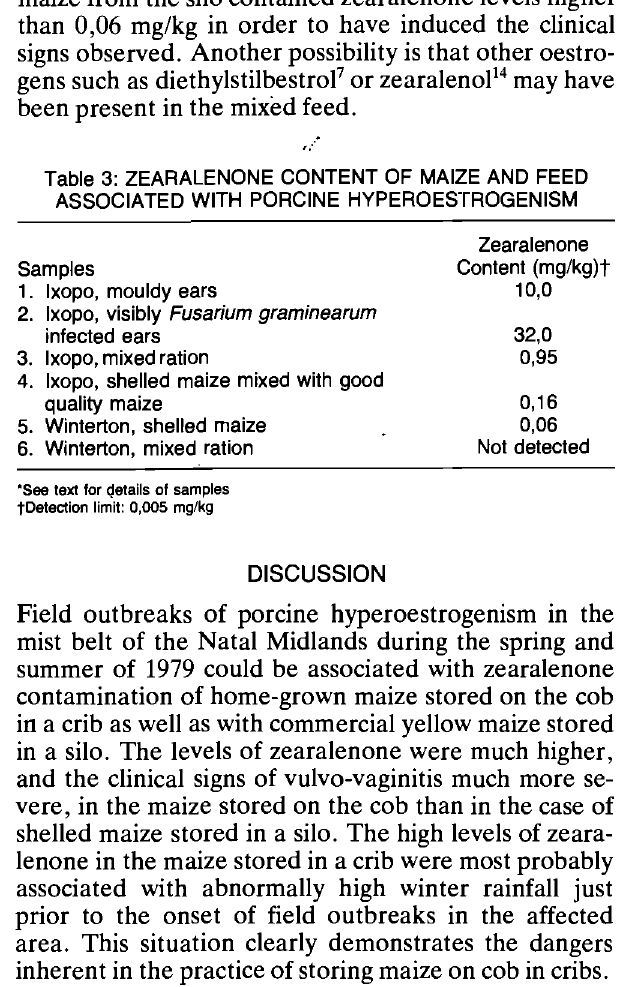
Samples 1. Ixopo, mouldy